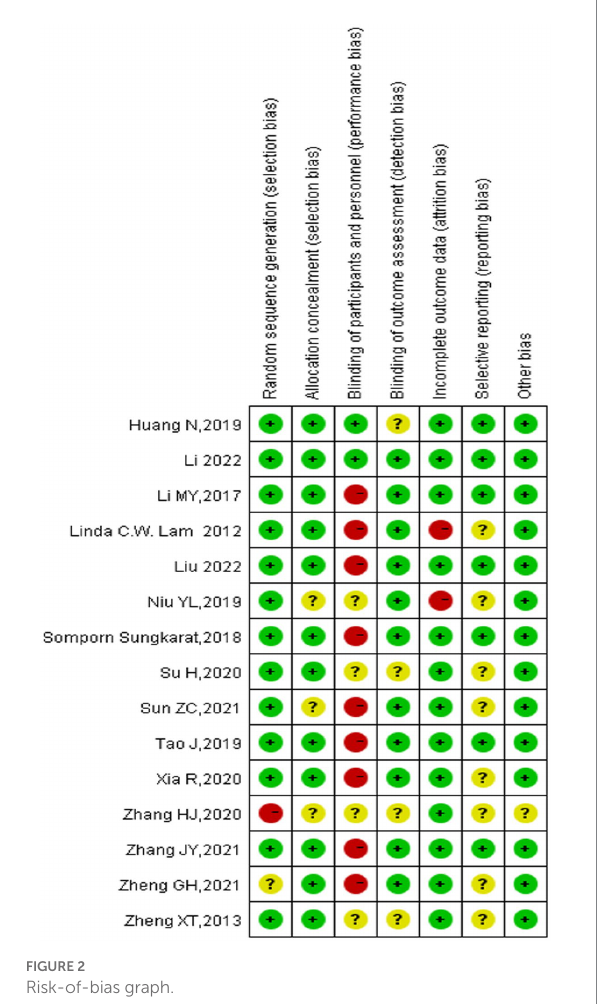
FIGURE 2 Risk-of-bias graph.